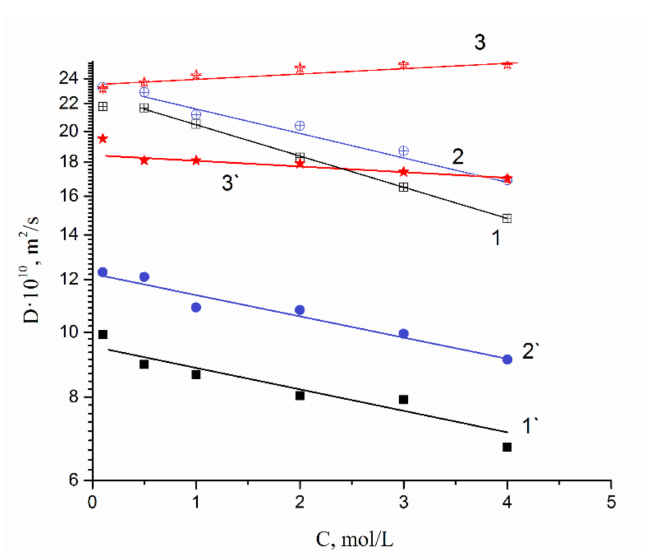
Figure 4. Water molecule and cation di ff usion coe ffi cient concentration dependences in lithium, sodium, cesium chloride aqueous solutions. 1–H 2 O in LiCl, 2–H 2 O in NaCl, 3–H 2 O in CsCl. 1 (cid:48) –Li + in